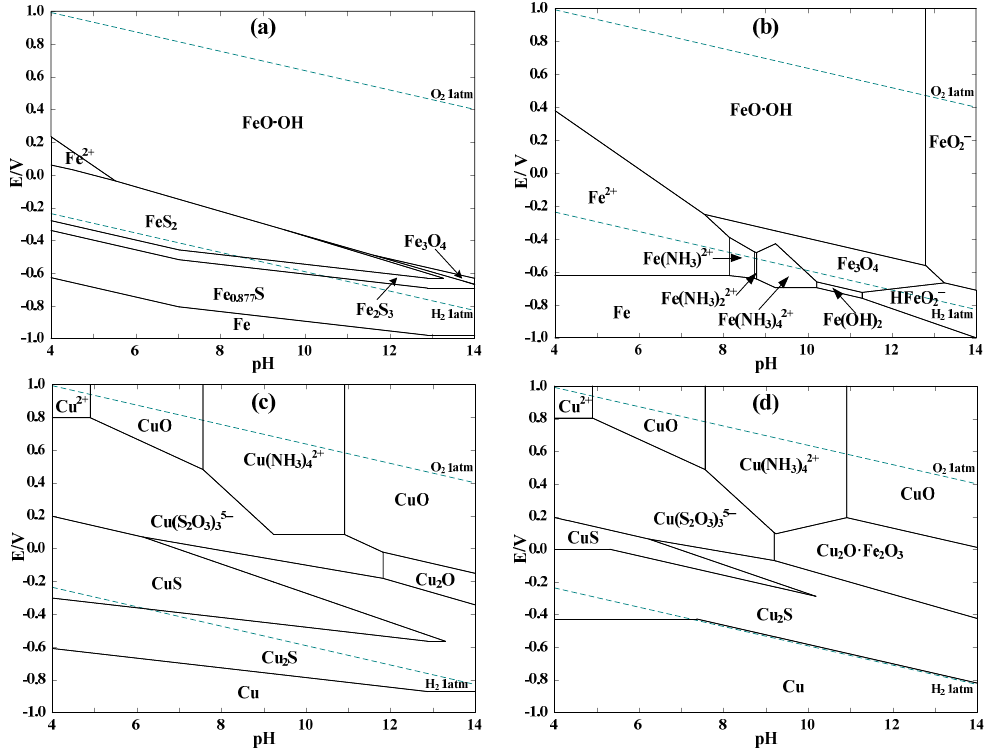
Figure 2. E-pH diagrams for systems of ( a ) Fe-S-H 2 O; ( b ) Fe-NH 3 -S 2 O 3 -H 2 O; ( c ) Cu-NH 3 -S 2 O 3 -H 2 O; and ( d ) Cu-Fe-NH 3 -S 2 O 3 -H 2 O. Conditions: ( a ) Fe 3 × 10 − 3 M, S 0.22 M; ( b ) Fe 1 × 10 − 5 M, NH 3 /NH